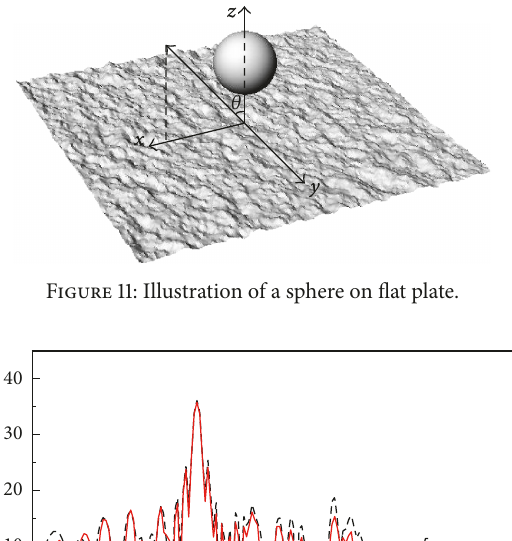
Figure 14: Bistatic RCS results of HH-polarization for the ship- ocean model.